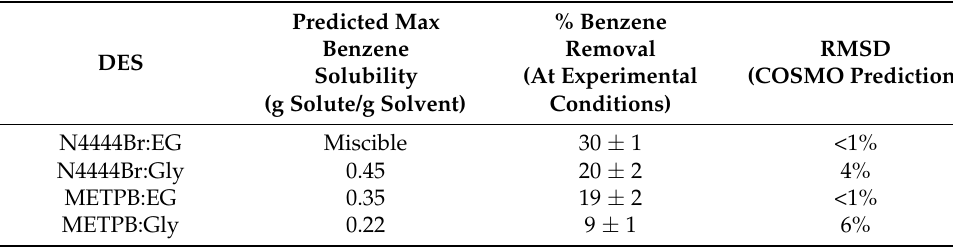
Table 3. Experimental and Model Predictions for DES